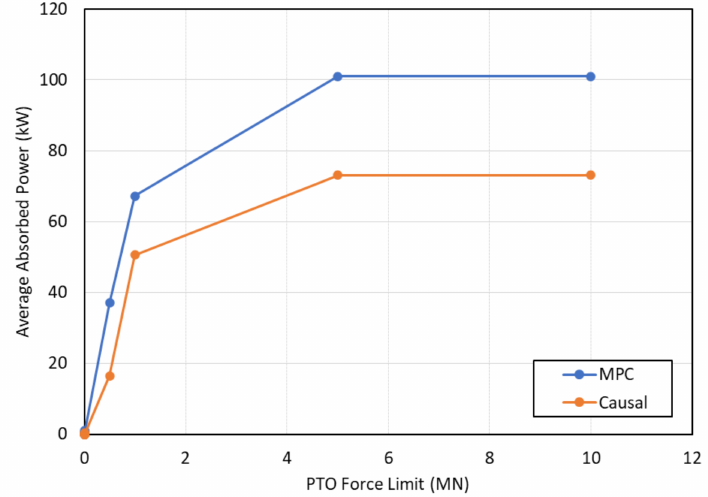
Figure 15. Average absorbed power vs. PTO force limit for wave input with Hs = 1 m, Tp = 16 s.